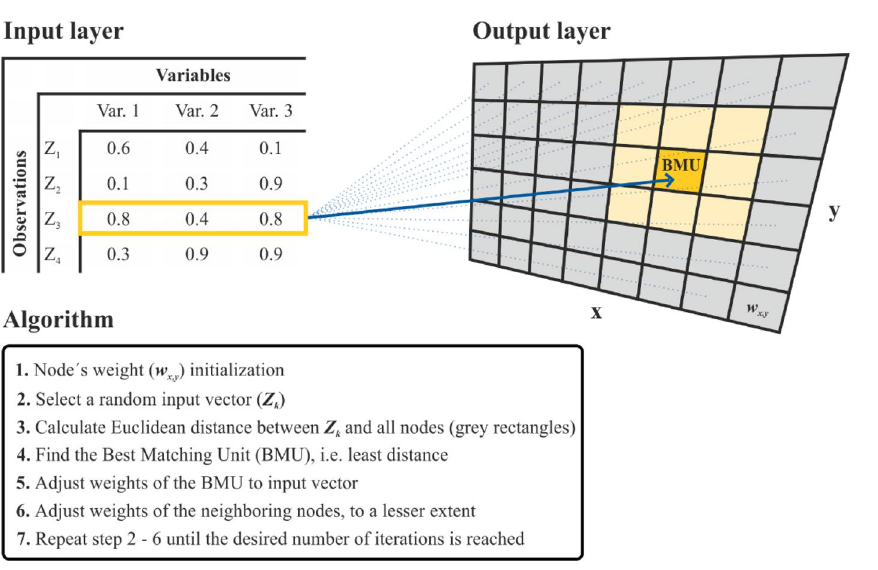
Figure 1. Architecture and learning process of a